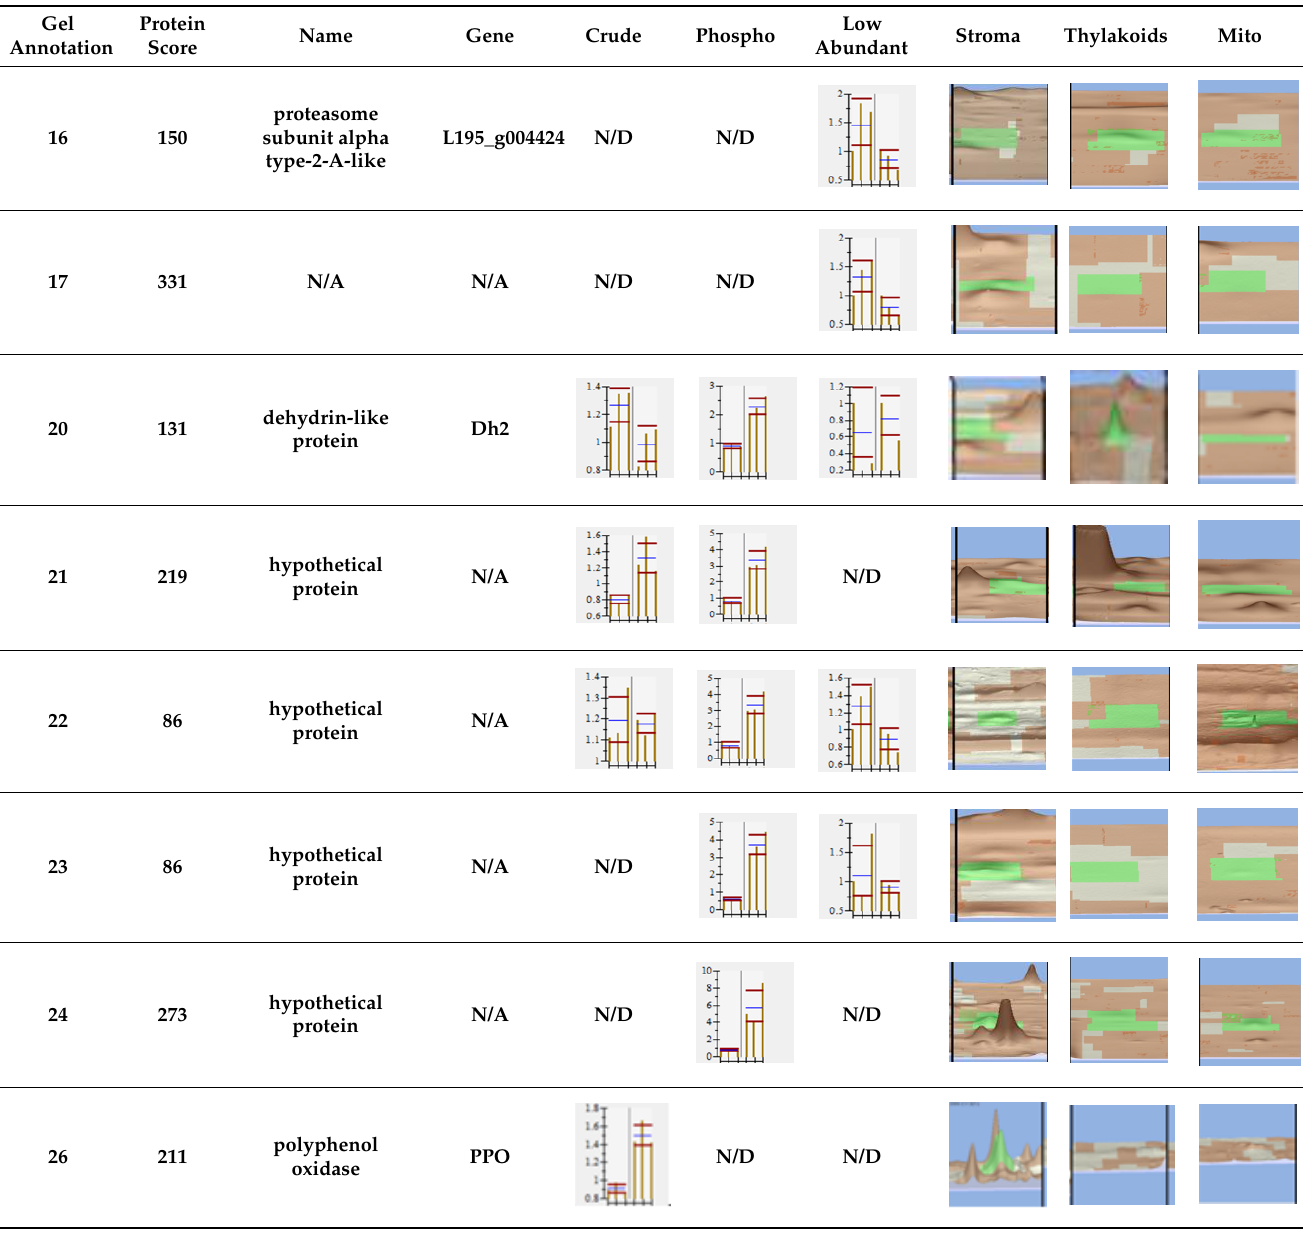
Figure 4. Immunoblot detection and analysis of dehydrins in H. rhodopensis . ( A ) Representative results from the 2D electrophoresis and immunoblotting of dehydrins. Proteins from a crude protein extract (mixture of internal standards for fresh and dry plants) were labeled with Cy5 (blue) and resolved using 2D electrophoresis with an isoelectric point (pI)/MW marker labeled with Cy2 (red). Subsequently, immunoblotting signals were detected with Cy3 (green). ( B ) Results of the 2D electrophoresis and quantitative analysis of proteins from fully hydrated and dry plants. (Upper panel) Representative gels. (Lower panel) 3D “landscape representation” of Dhn1 and Dhn2 from fully hydrated and dry plants with their corresponding relative abundances. ( C ) Immunoblot analysis of dehydrin expression at selected states of desiccation stress. C—watered plants; D1—moderate desiccation;